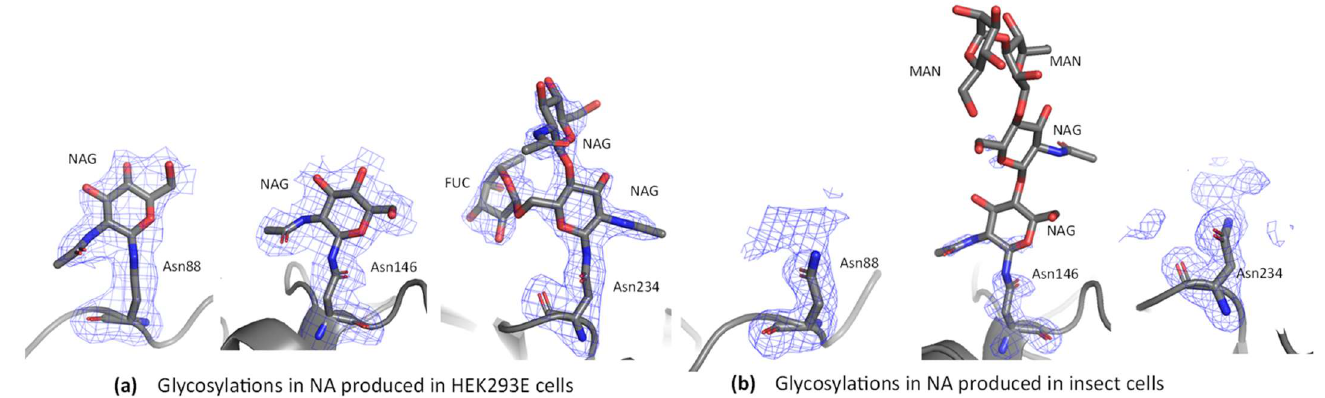
Figure 9. Glycosylations in NA. ( a ) NA glycosylations at Asn88, Asn146 and Asn234 in HEK293-6E produced NA. These images were made in PyMOL, with polder maps (blue mesh) contoured to 4σ. ( b ) For comparison the polder maps for the same residues from 3BEQ the insect cell H1N1 NA structure. Electron density for all chains can be found in Figures S5–S7.